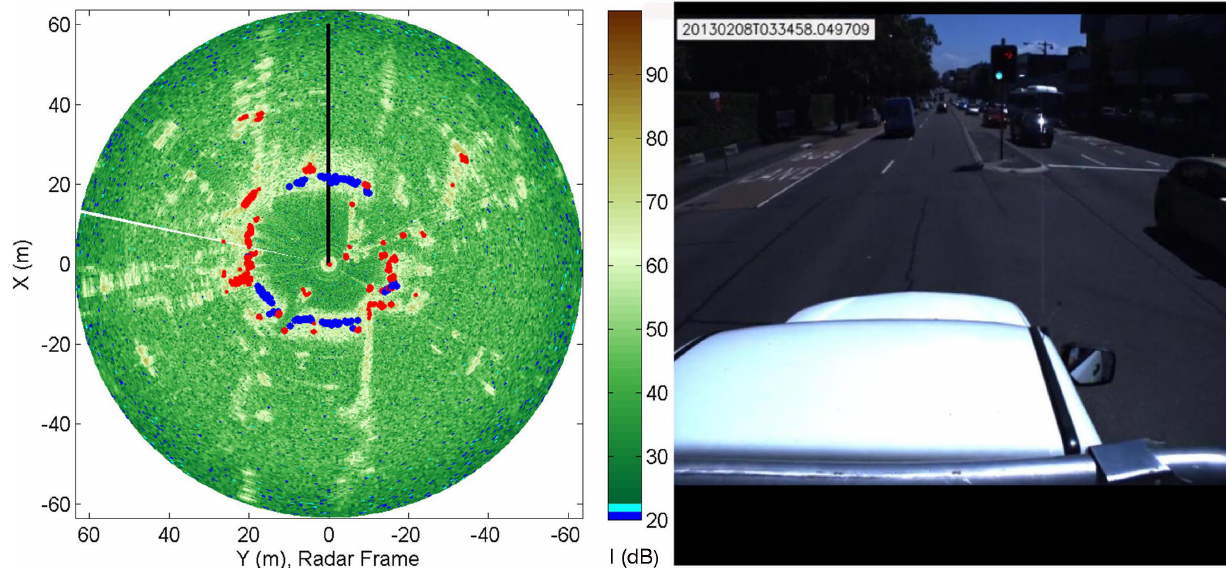
Figure 11. Output of the RCGD algorithm overlaid over the radar image ( Left ) in a cluttered urban environment ( Right ). Blue dot: Radar-labelled